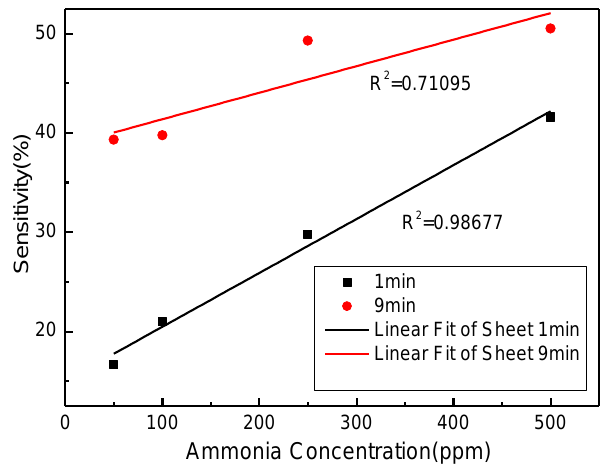
Figure 6. Sensitivity ( a ) and Raman spectrum ( b ) of ion sensitive GO-Si based metal-semiconductor junction resistor gas sensor with different time lengths of UVO processing.